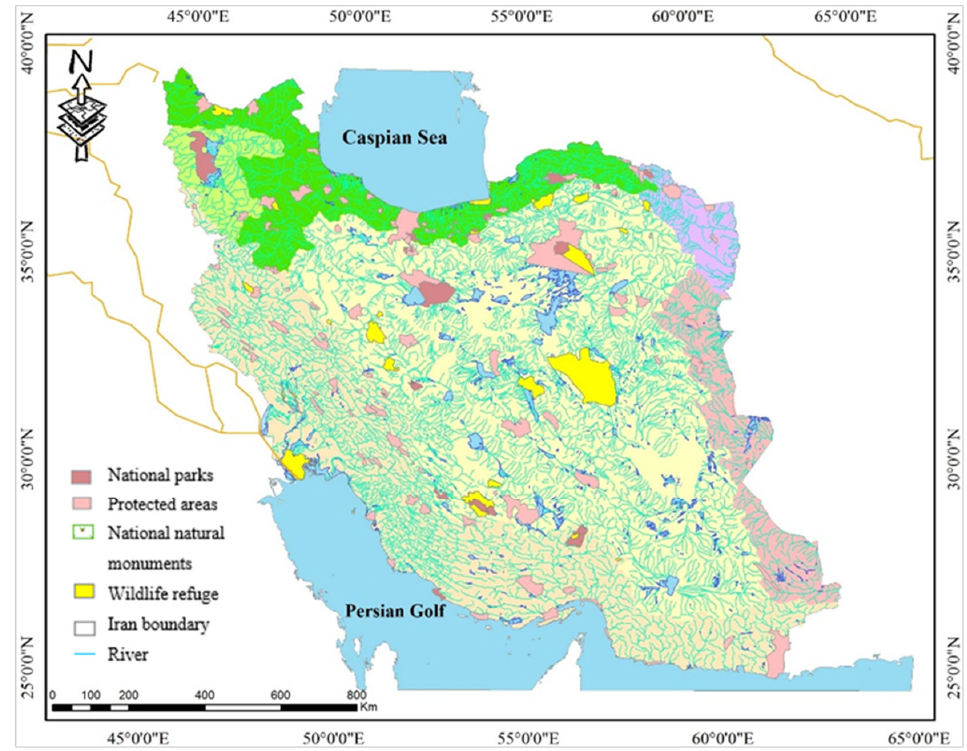
Figure 6. Water bodies located in the Protected Areas (PAs) of Iran.